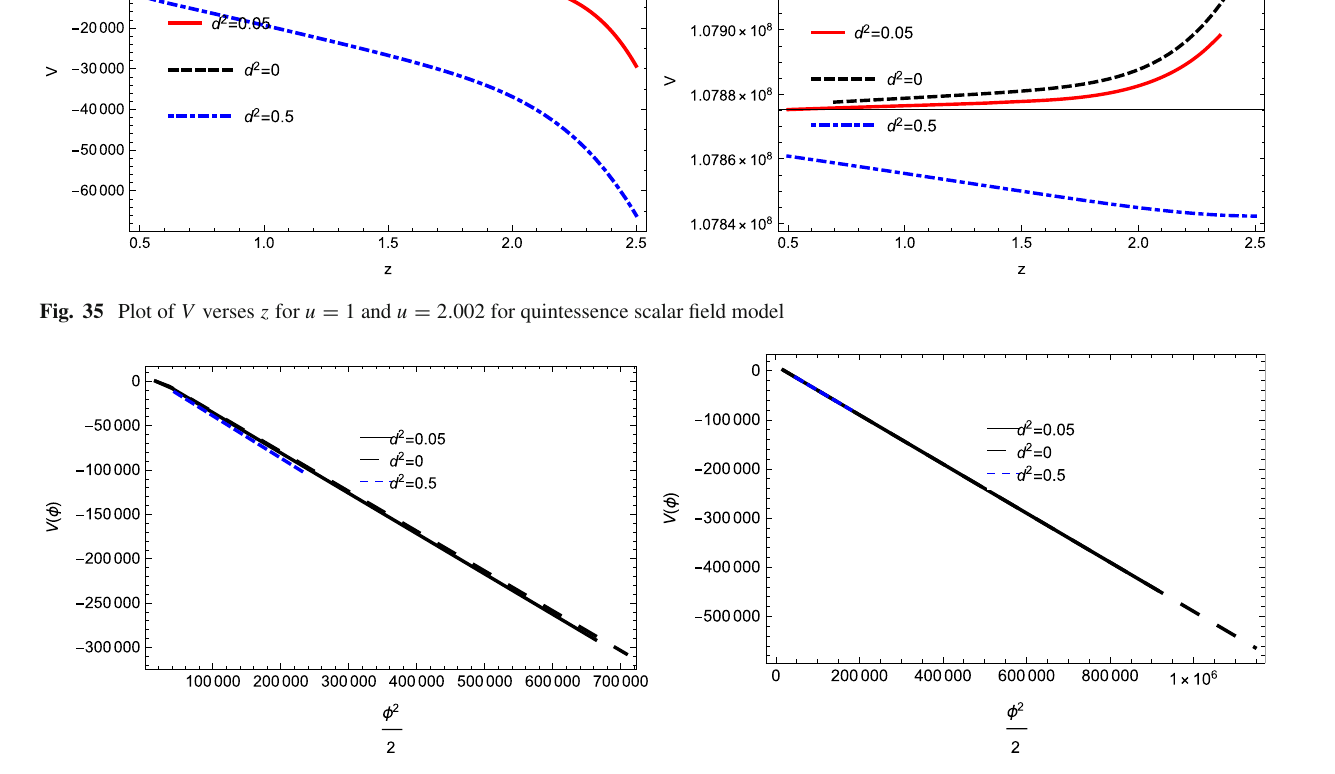
Fig. 36 Plot of φ( z ) verses V ( z ) for u = 1 and u = 2 . 002 for quintessence scalar field model